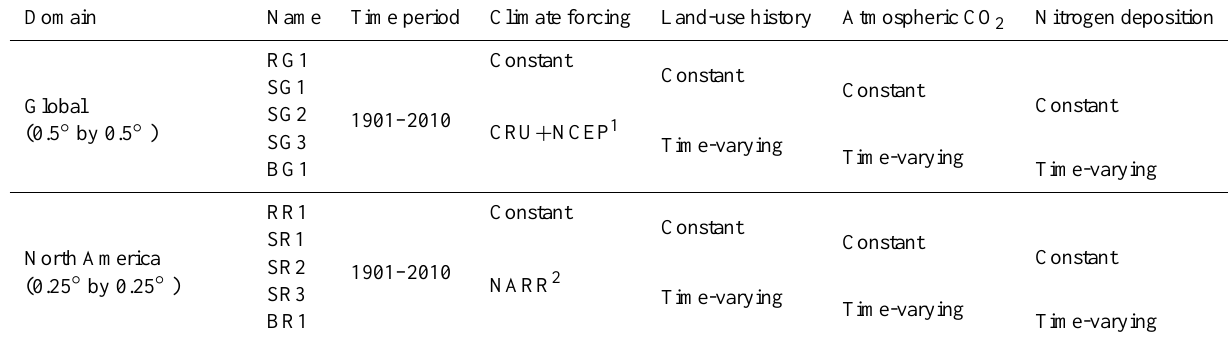
Table 3. Series of MsTMIP